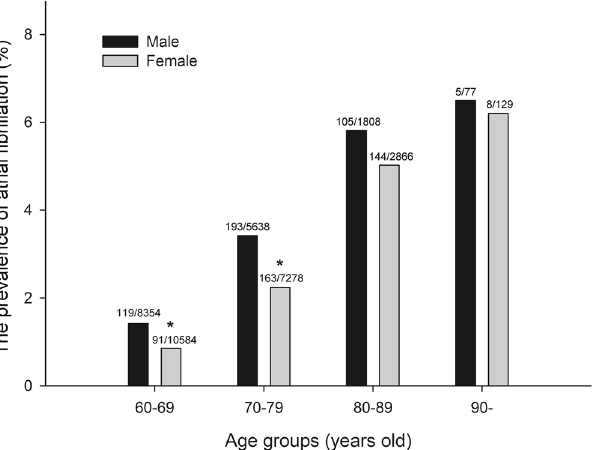
Figure 2. The prevalence of atrial fibrillation in various age groups. Compared with the males in the same age group, * Indicated P <